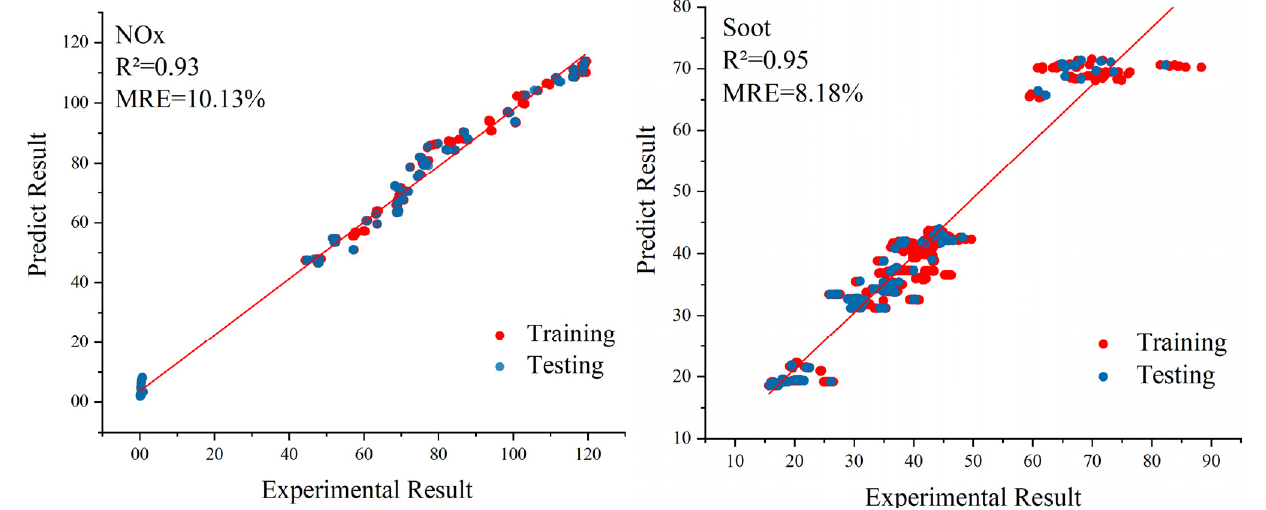
Figure 5. ANN results diagrams. Figure 5.